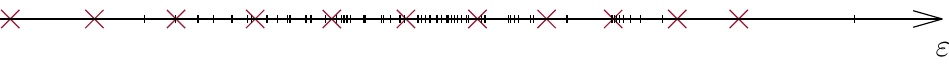
Figure 2 . The eigenvalues of (3.19) in the block ( N = 15 , M = 12 ) at δ = 3 , computed by numerical diagonalization of the relevant Hamiltonian block. Generic eigenvalues are depicted as vertical bars and ladder state energies as red crosses. The lowest energy eigenvalue is a ladder eigenvalue, given by (5.1), at ε min = 57 and the highest eigenvalue is given by ε max = N ( N − 1) / 2 = 105 , which is I I the single eigenvalue originating from the block ( N, 0